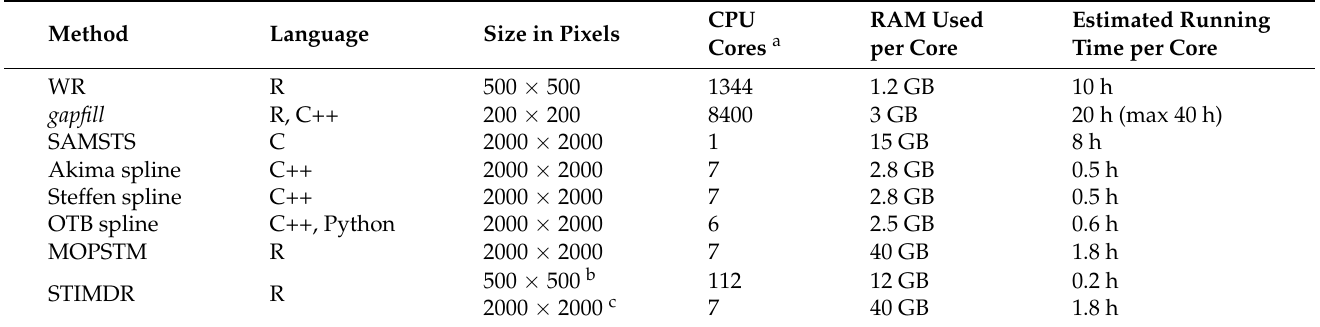
Table 5. The computational efficiency of the gap-filling methods: WR, gapfill , SAMSTS, Akima spline, Steffen spline, OTB spline, MOPSTM, and